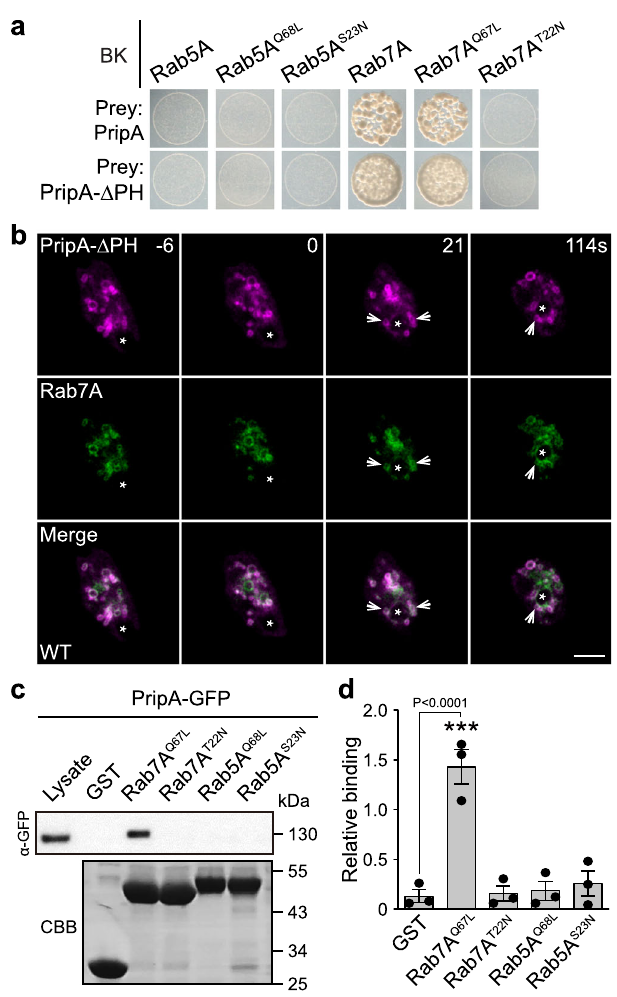
Fig. 4 PripA interacts with the active form of Rab7. a Yeast two-hybrid assay showing that PripA and PripA- Δ PH interacted speci fi cally with WT and the constitutively active (CA) form of Rab7A (Rab7A Q67L ), but not the dominant negative (DN) form of Rab7A (Rab7A T22N ), Rab5A, the CA form of Rab5A (Rab5A Q68L ), or the DN form of Rab5A (Rab5A S23N ). b Colocalization of PripA- Δ PH-RFP and GFP-Rab7A on late macropinosomes. The Pearson ’ s correlation coef fi cient was 0.86 ± 0.06 (mean ± SEM, n = 8 cells). c Top: Western blot from pull-down of GST control beads or GST-fused CA or DN forms of Rab5A and Rab7A beads with cell lysate expressing PripA-GFP. Bottom: the protein-transferred membrane was stained with coomassie brilliant blue (CBB) to show puri fi ed GST fusion proteins. d Densitometry showing relative binding of PripA-GFP to different GST fusion proteins (means ± SEM). Data were from 3 independent experiments. Signi fi cance was determined by one-way ANOVA with Dunnett posttest. Scale bar = 5 μ m. Source data for c , d are provided in this CA form of Rab7A (Rab7A Q67L ) but not the dominant negative (DN) form of Rab7A (Rab7A T22N ) or either form of Rab5A (Rab5A Q68L and Rab5A S23N ) (Fig. 4c, d; Supplementary Fig. S4d). Therefore, PI(3,4)P 2 and Rab7 mediate the recruitment of PripA to macropinosomes.